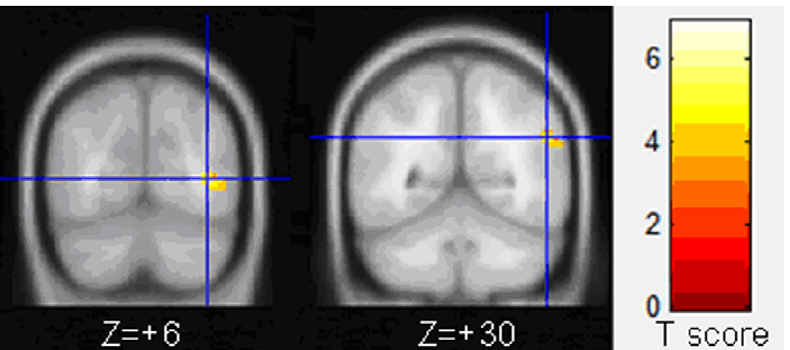
Figure 2. Whiter matter regions with lower FA in adult strabismus. White matter regions with lower FA in strabismus patients, including right middle occipital gyrus (Z= + 6) and right supramarginal gyrus (Z= +